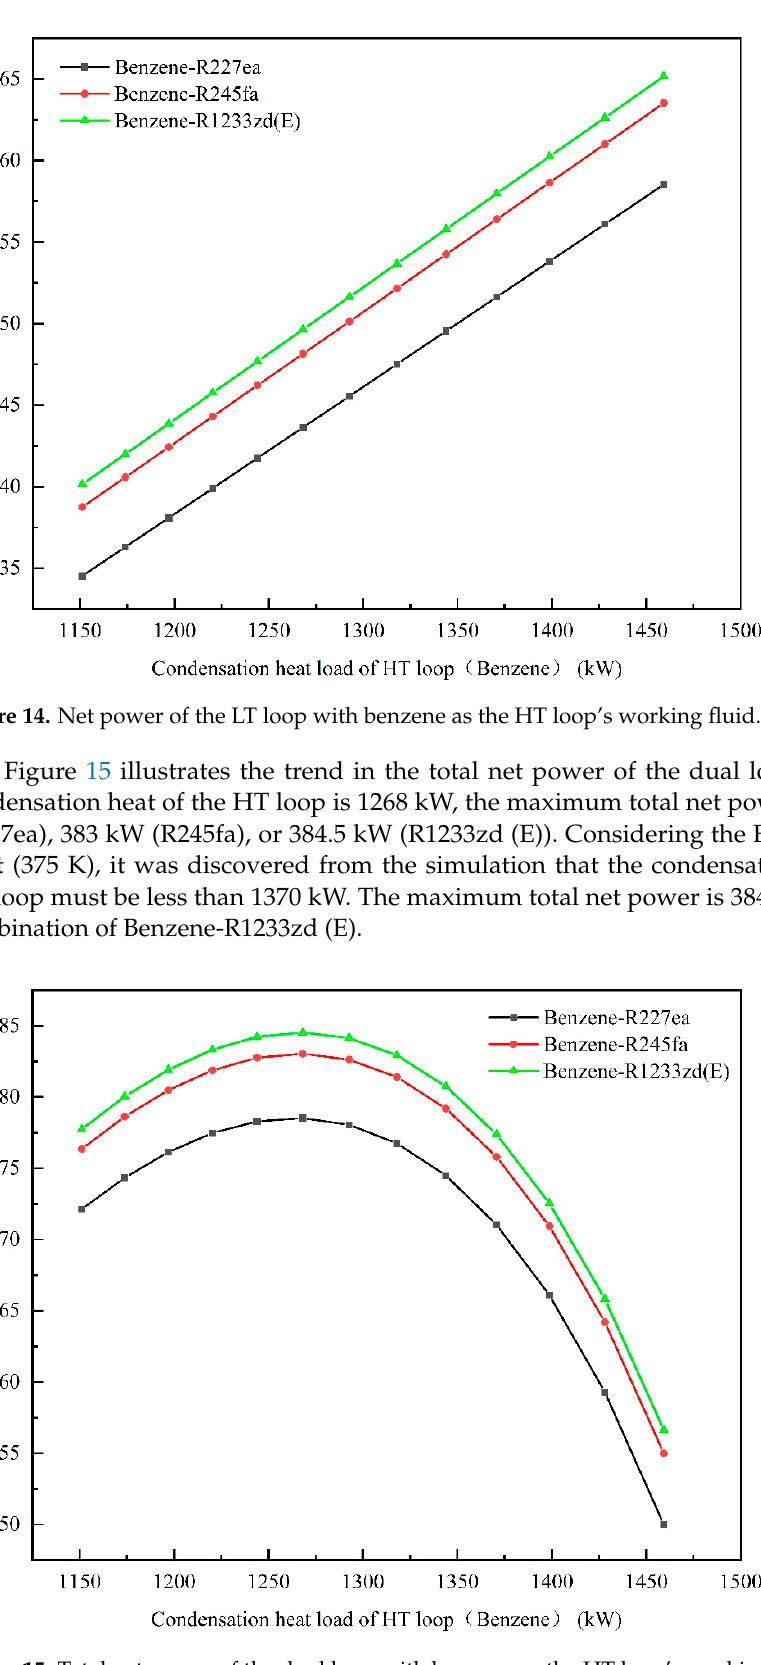
Figure 15. Total net power of the dual loop with benzene as the HT loop’s working